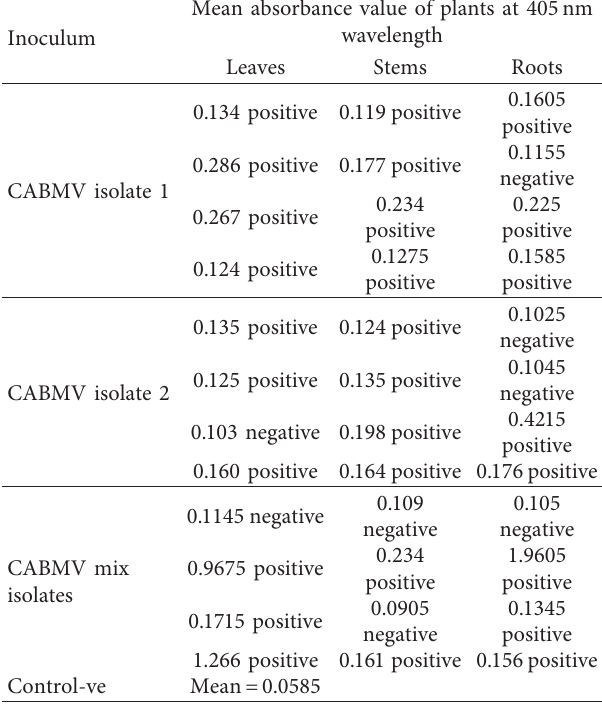
Table 3: Determination of potyvirus presence in P. edulis plants parts by ACP-ELISA.